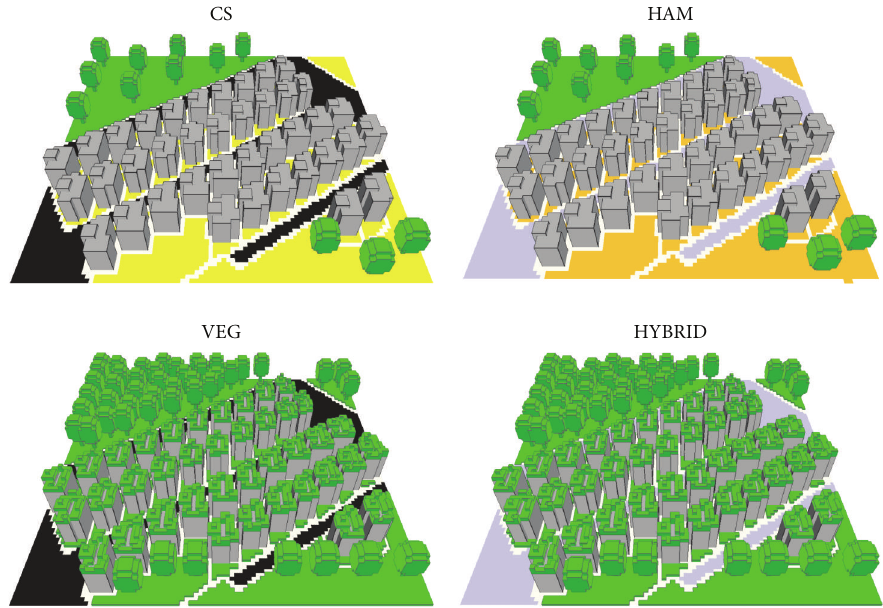
Figure 10: The current situation of the study area (CS) as well as with consideration of three mentioned UHI mitigation strategies; HAM: high albedo materials; VEG: greenery; HYBRID: